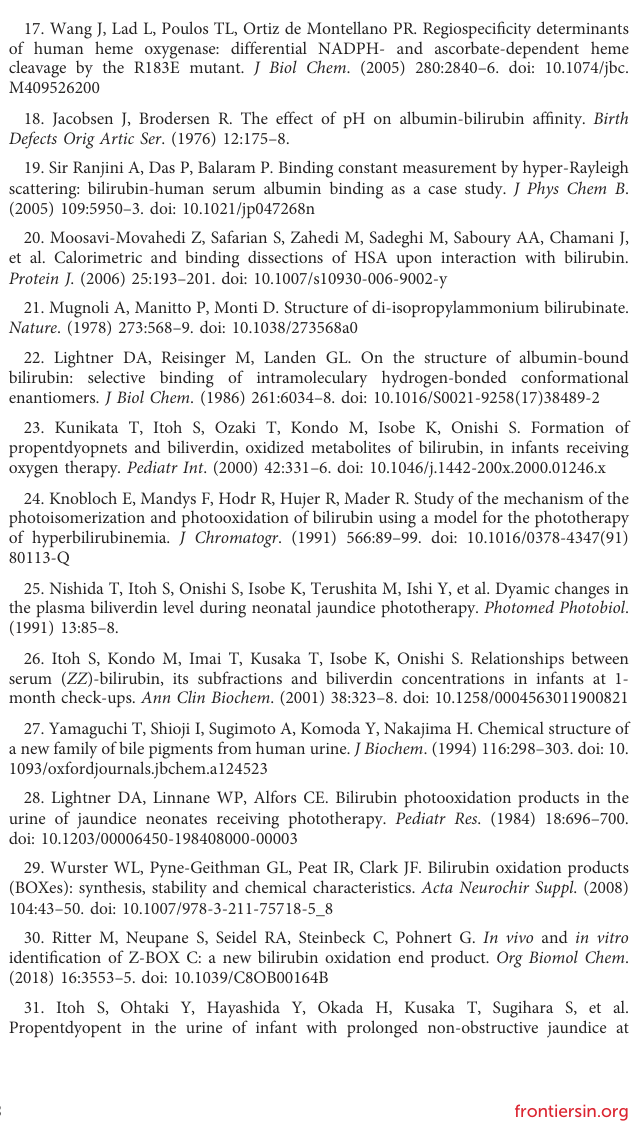
table. KK, SN, and TK performed English editing and literature review. TK critically reviewed the manuscript. All authors contributed to the article and approved the submitted